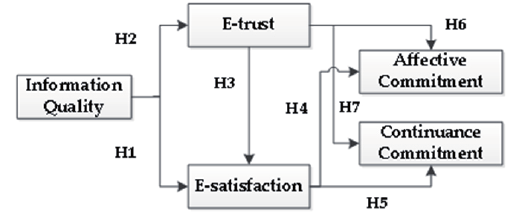
Fig.1 Theoretical